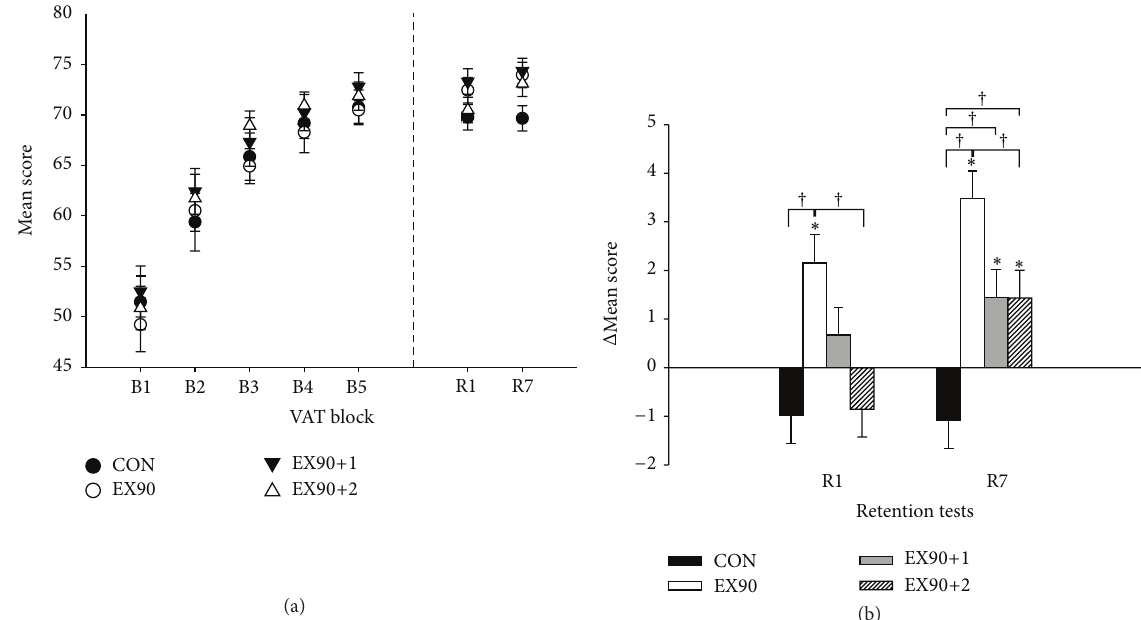
Figure 3: (a) Mean scores ( ± SE) in the VAT at acquisition blocks 1–5 and at 1d (R1) and 7 d (R7) retention. (b) Changes in mean scores ( ± SE) for all groups in the VAT from B5 to R1 and R7. ∗ Significant change from B5 ( 𝑝 < 0.05 ). † Significant between-group difference ( 𝑝 < 0.05 ).